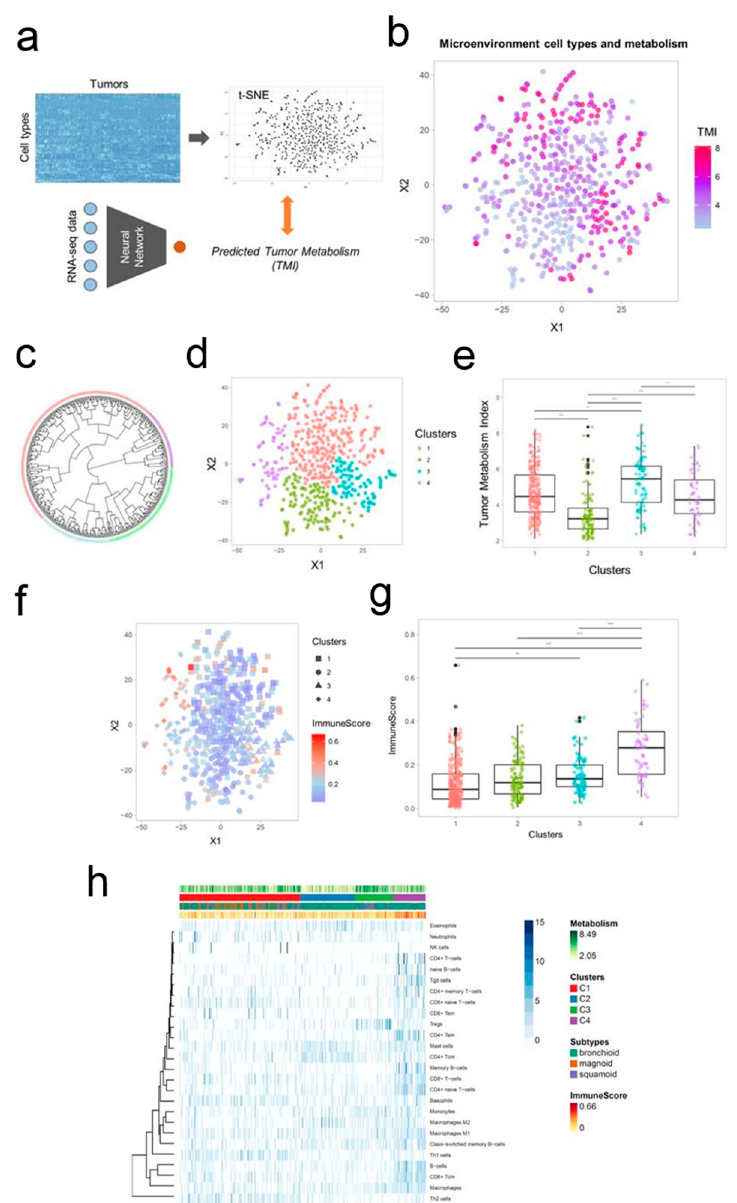
Figure 4. A schematic representation of the two-dimensional projection of cellular landscape of tumor microenvironment. ( a ) Data from The Cancer Genome Atlas (TCGA) were analyzed and represented in a two-dimensional tumor microenvironment landscape map resorting to t-distributed stochastic neighborhood embedding ( t -SNE) based on the scores reflecting the enrichment of cell types. ( b ) Gradient color representing the tumor metabolism index (TMI) of each sample, showing that hypometabolic samples are placed within populations with low values. ( c ) Circular dendrogram for the groups identified by hierarchical cluster analysis. ( d ) Two-dimensional map of the tumor microenvironment landscape reflecting the similarity between samples. ( e ) Selected clusters displaying significantly different tumor metabolic index (TMI). ( f ) Two-dimensional map of the tumor microenvironment landscape with the ImmuneScore information. ( g ) ImmuneScores were significantly different between the clusters. ( h ) A composed view of the results including the heatmap showing the scores of the enrichment of each immune cell type, the tumor metabolism index, the groups identified based on immune cellular heterogeneity, lung adenocarcinoma subtypes, and ImmuneScore. Reprinted from [113] under a CC BY-NC 4.0 license. Copyright Ivyspring International Publisher, 2018.